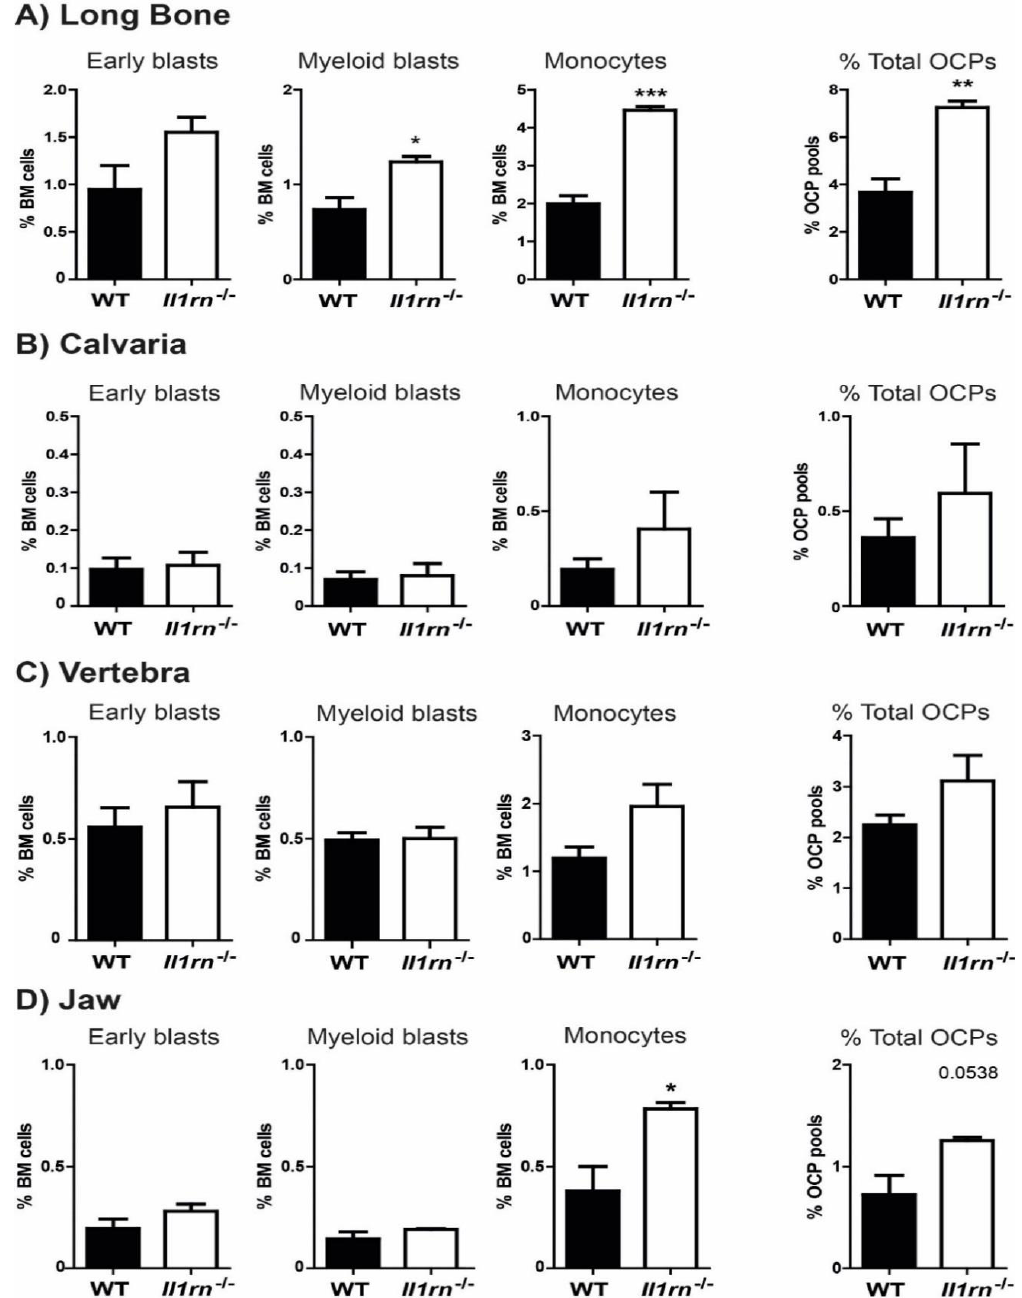
Figure 2. Absence of IL-1RA increases the percentage of myeloid blasts in long bone, and the percentage of monocytes in long bone and jaw. Percentage of early blasts, myeloid blasts, and monocytes from long bone ( A ), calvaria ( B ), vertebra ( C ), and jaw ( D ) were quantified and compared between wild-type (WT) (black bars) and Il1rn − / − (white bars) mice ( n = 6, * p < 0.05 ** p < 0.01, *** p < 0.001). Whereas the calvaria and vertebral bone marrow (BM) of Il1rn − / − mice showed no significant di ff erences in the percentage of various osteoclast precursor subsets, we found a significant increase of both the myeloid blasts and monocyte subsets in the BM of long bone. Similarly, the monocyte subset of OCPs was also significantly increased in the jaw BM of Il1rn − / − mice as compared to WT controls.